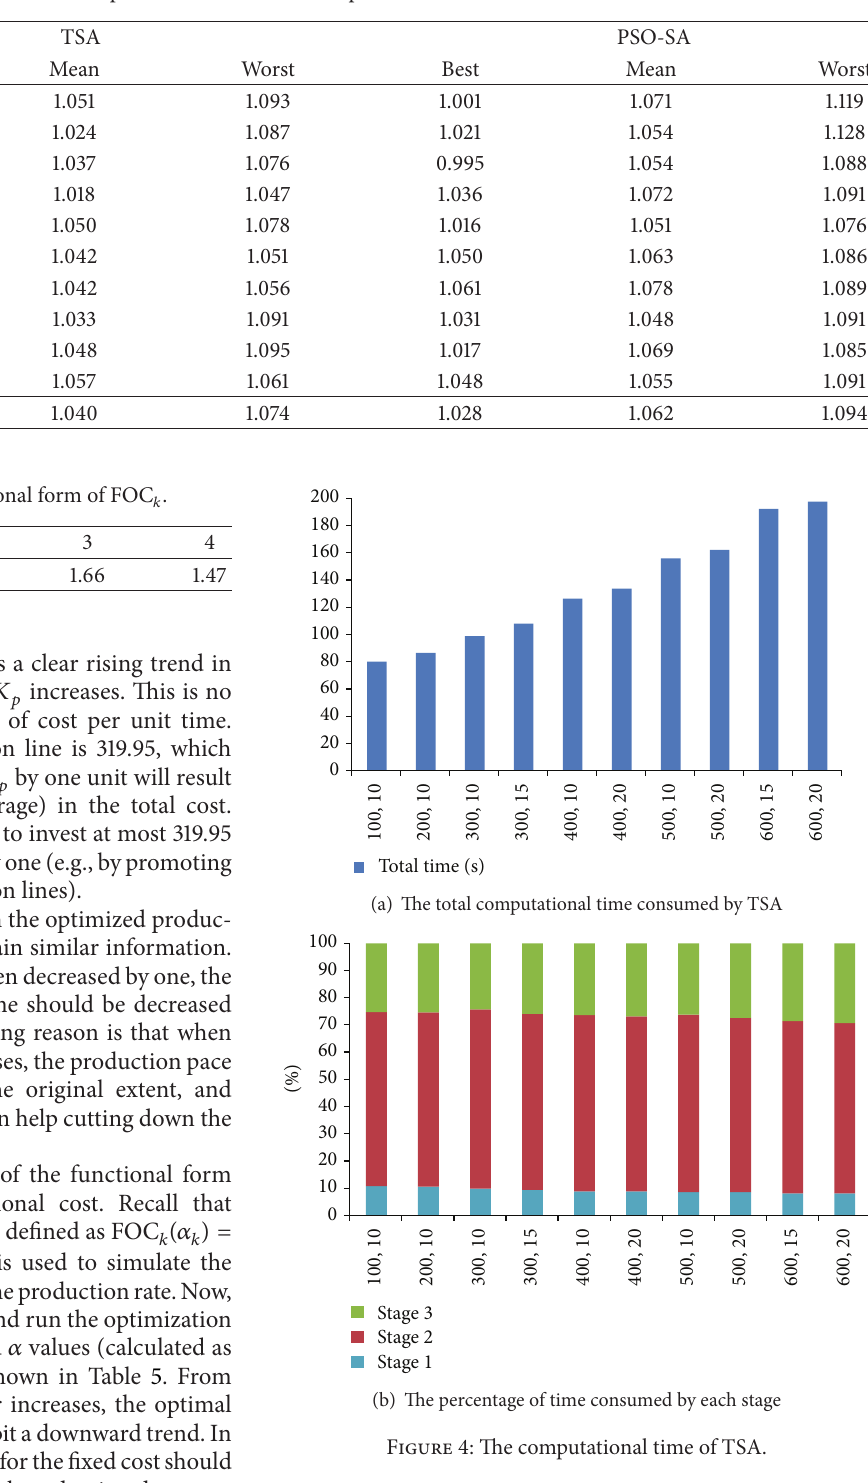
Table 4: The computational results under exponential distributions.